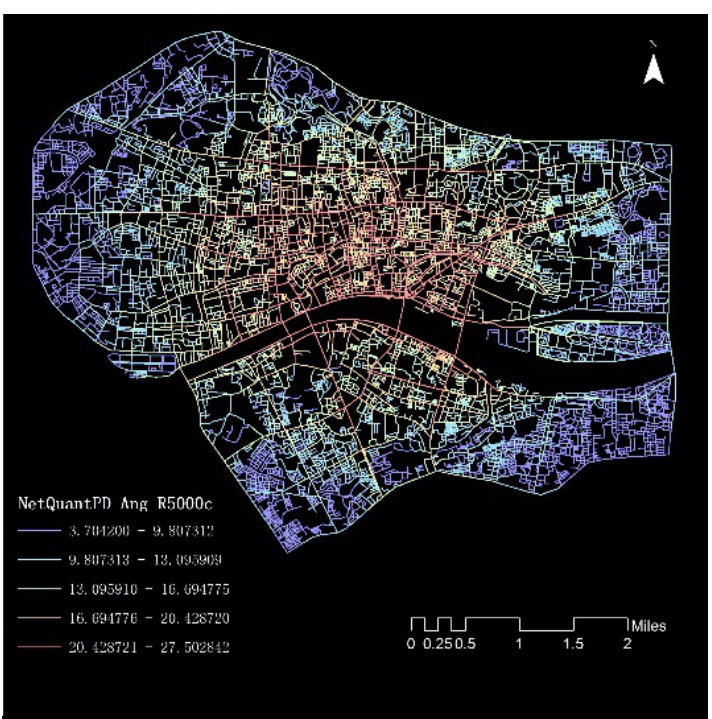
Fig. 10 The regional closeness of 5000m radius